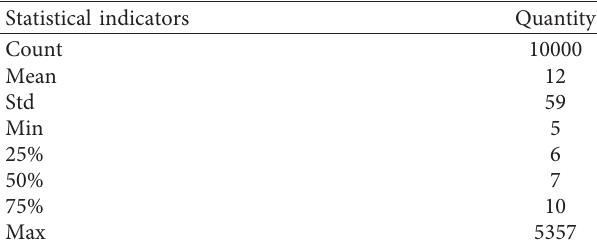
Figure 4: Schematic diagram of the model structure. Table 1: User reading distribution